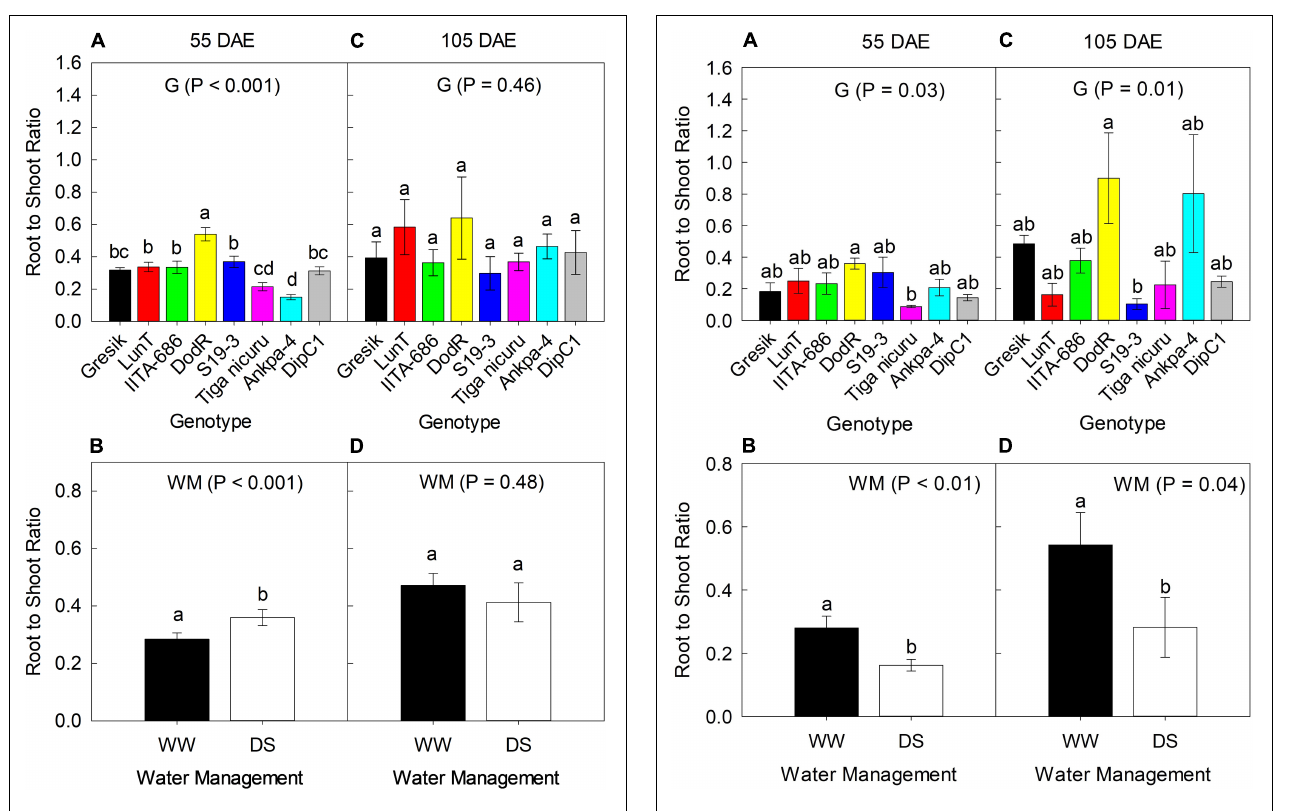
FIGURE 3 | Effect of Genotype (G) — (A,C) at 55 and 105 DAE (50 days of DS recovery), respectively, the data is mean ± SE values ( n = 6) and WM — (B,D) at 55 and 105 DAE (50 days of DS recovery), respectively, the data is mean ± SE values ( n = 24) on root to shoot ratio (R:S) of eight bambara groundnut genotypes during the 2018 season. Different letters showing significant differences by Tukey’s honest significant difference post hoc test for treatments.